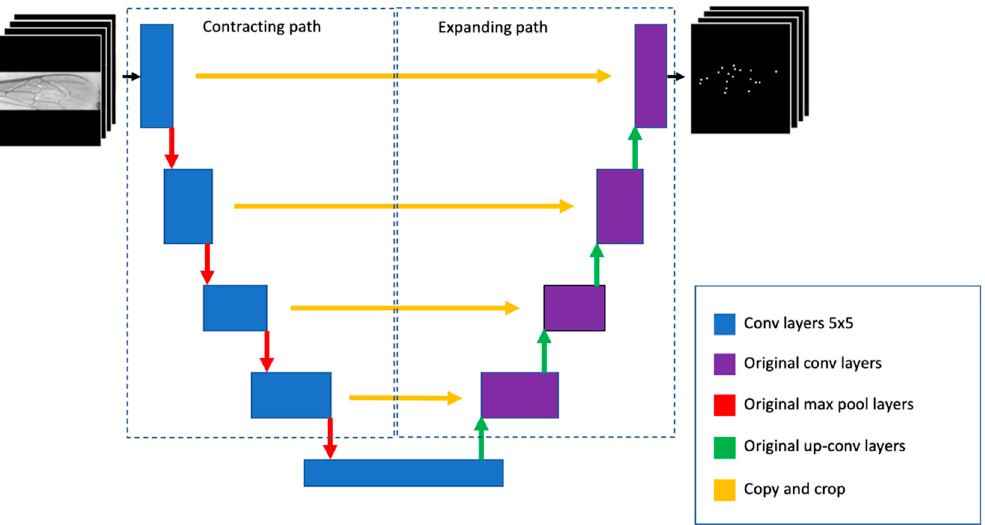
Figure 9. U-Net architecture used for segmentation of the landmarks. It is based on CNN with a contracting path to capture context and a symmetric expanding path to enable precise landmark positioning.